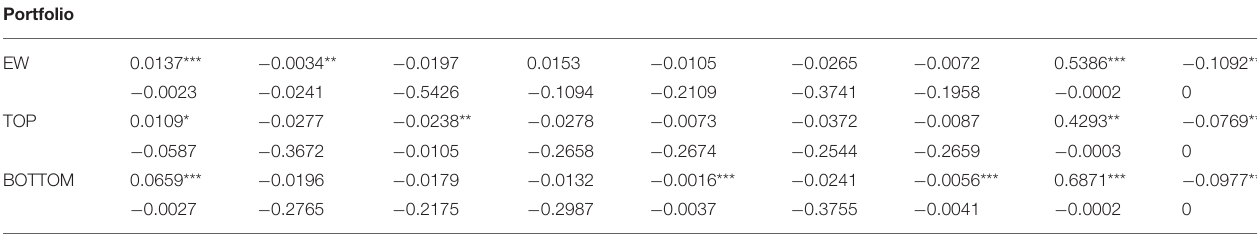
TABLE 5 | Linear regression results based on all DRNs.